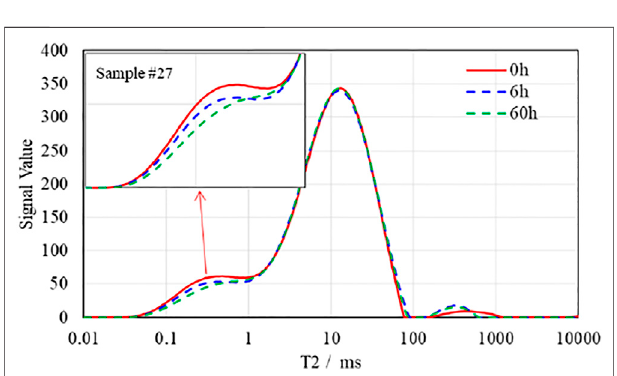
FIGURE 3 | Results of imbibition – NMR experiments under high temperature and pressure conditions.